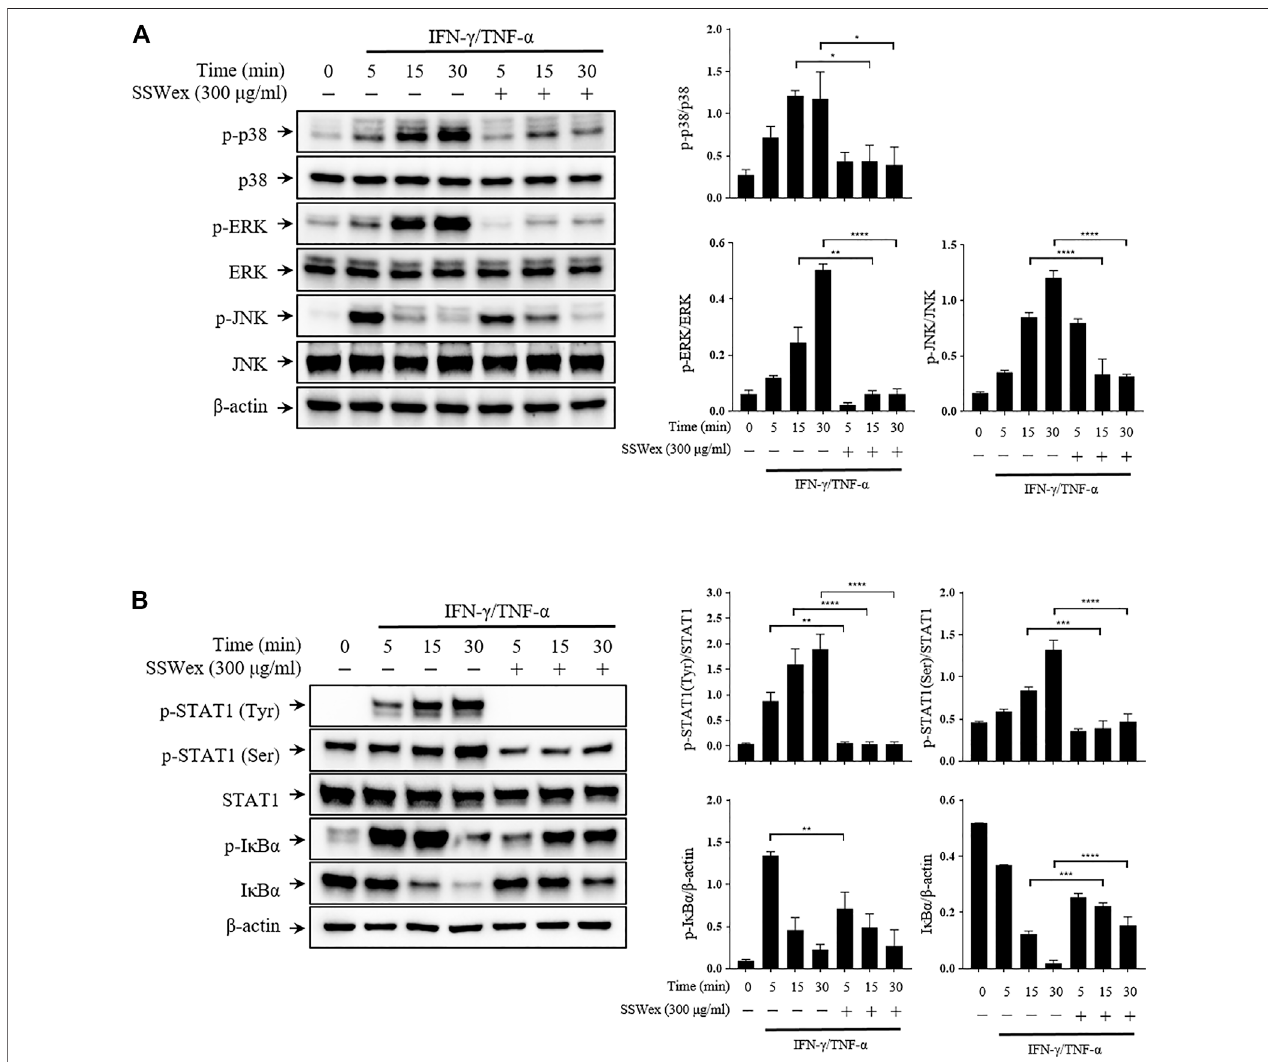
FIGURE 6 | Effect of SSWex on MAPK/NF- κ B/STAT1 activation by IFN- γ -/TNF- α in HaCaT cells. The cells were preincubated with SSWex for 1 h and further stimulatedwith IFN- γ /TNF- α forvarious time intervals (0, 5, 15,and 30 min). Using aWestern blotanalysis, (A) thephosphorylatedand total MAPK (p38, ERK, and JNK) protein levels were quanti fi ed and (B) phosphorylation or degradation of I κ B α and STAT1 proteins was detected in the cells. Quanti fi ed Western blot data are shown as the means ± S.E.M. of three separate experiments. * p < 0.05, ** p < 0.005, *** p < 0.0005, and **** p < 0.0001 vs. IFN- γ /TNF- α .